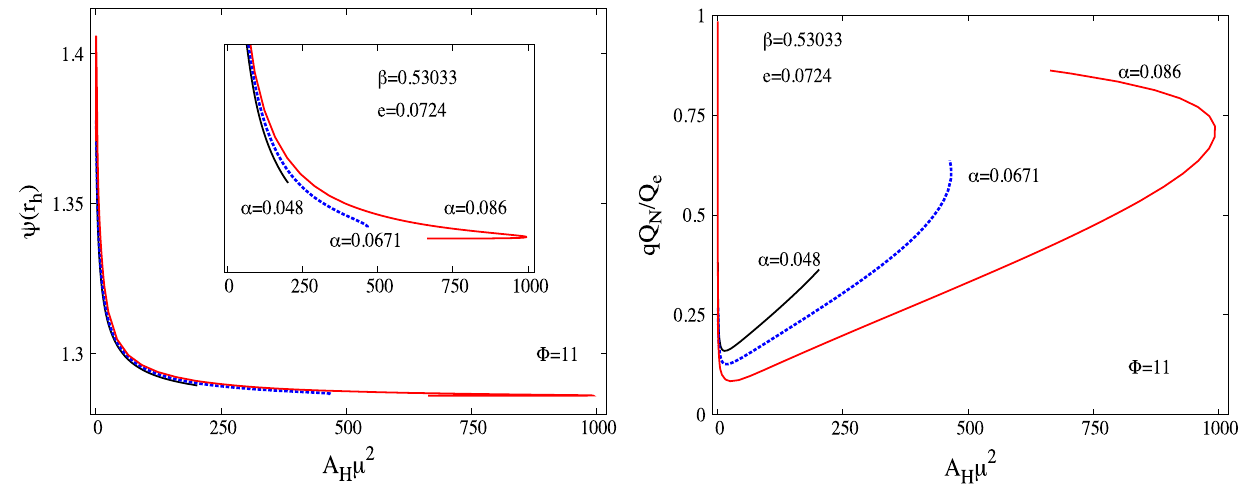
Fig. 4 Value of the scalar field at the horizon ψ h (left panel) and the hairiness parameter qQ N / Q e (right panel) v s . the horizon area, for the same solutions as in Fig.